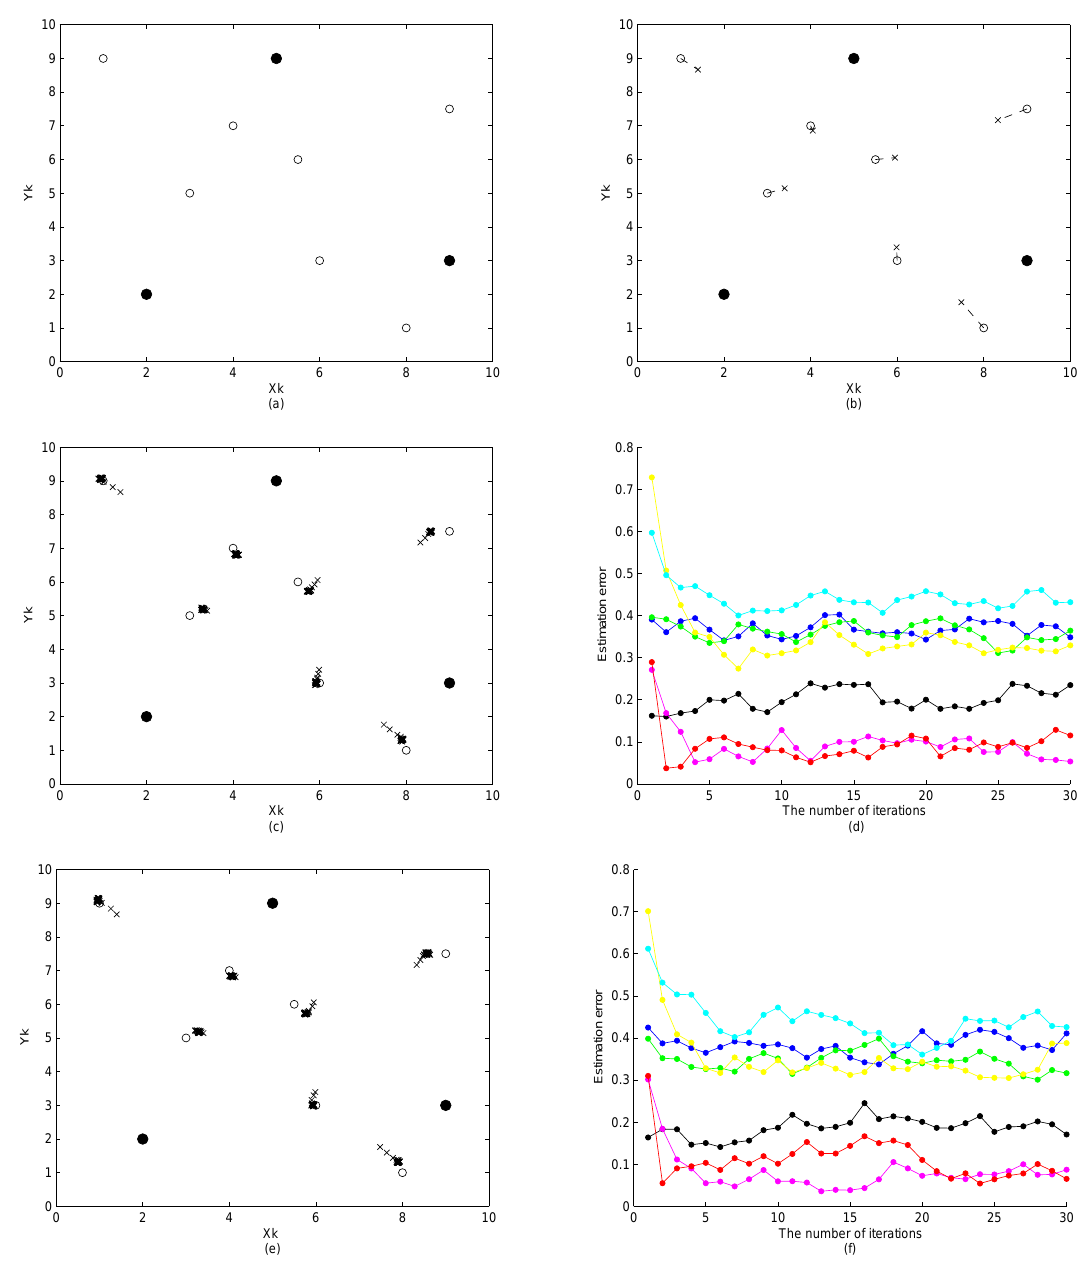
= 0 . 1 and σ 2 = 0 . 5 d ε